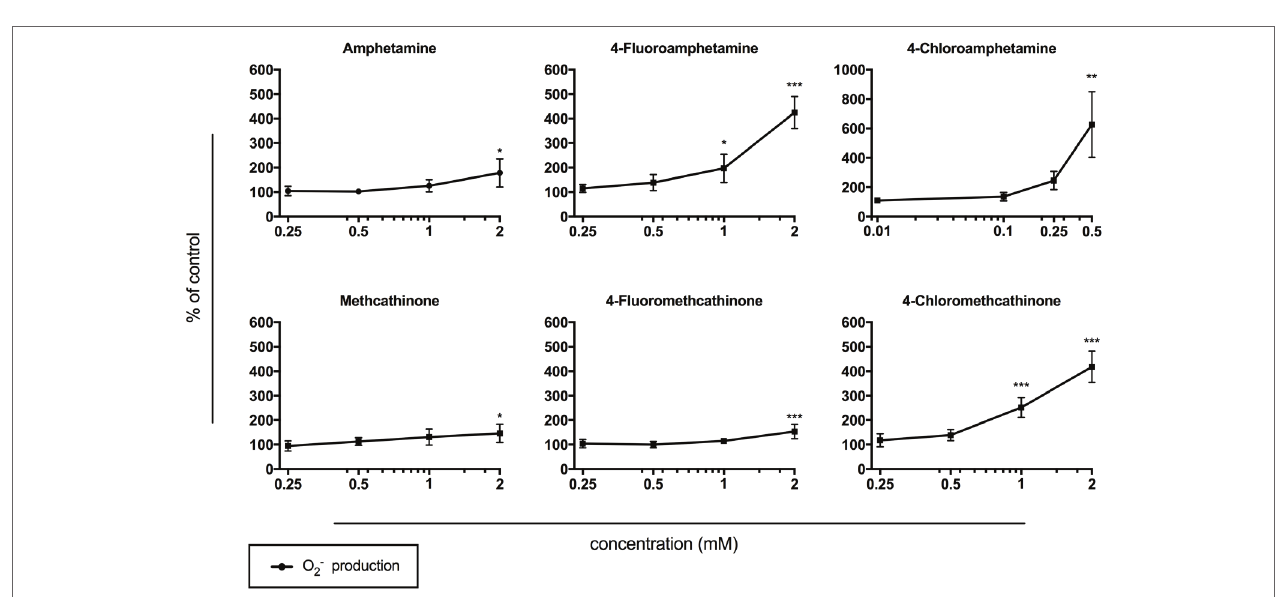
FIGURE 5 | Mitochondrial superoxide production in HepG2 cells after drug exposure for 24 h. Data are expressed as mean ± SEM adjusted to protein content. Numbers in parentheses indicate the number of individual experiments performed in triplicate: amphetamine (5), 4-fluoroamphetamine (4), 4-chloroamphetamine (3), methcathinone (5), 4-fluoromethcathinone (4), and 4-chloromethcathinone (3). Significance levels are given as * p < 0.05, ** p < 0.01, *** p < 0.001.